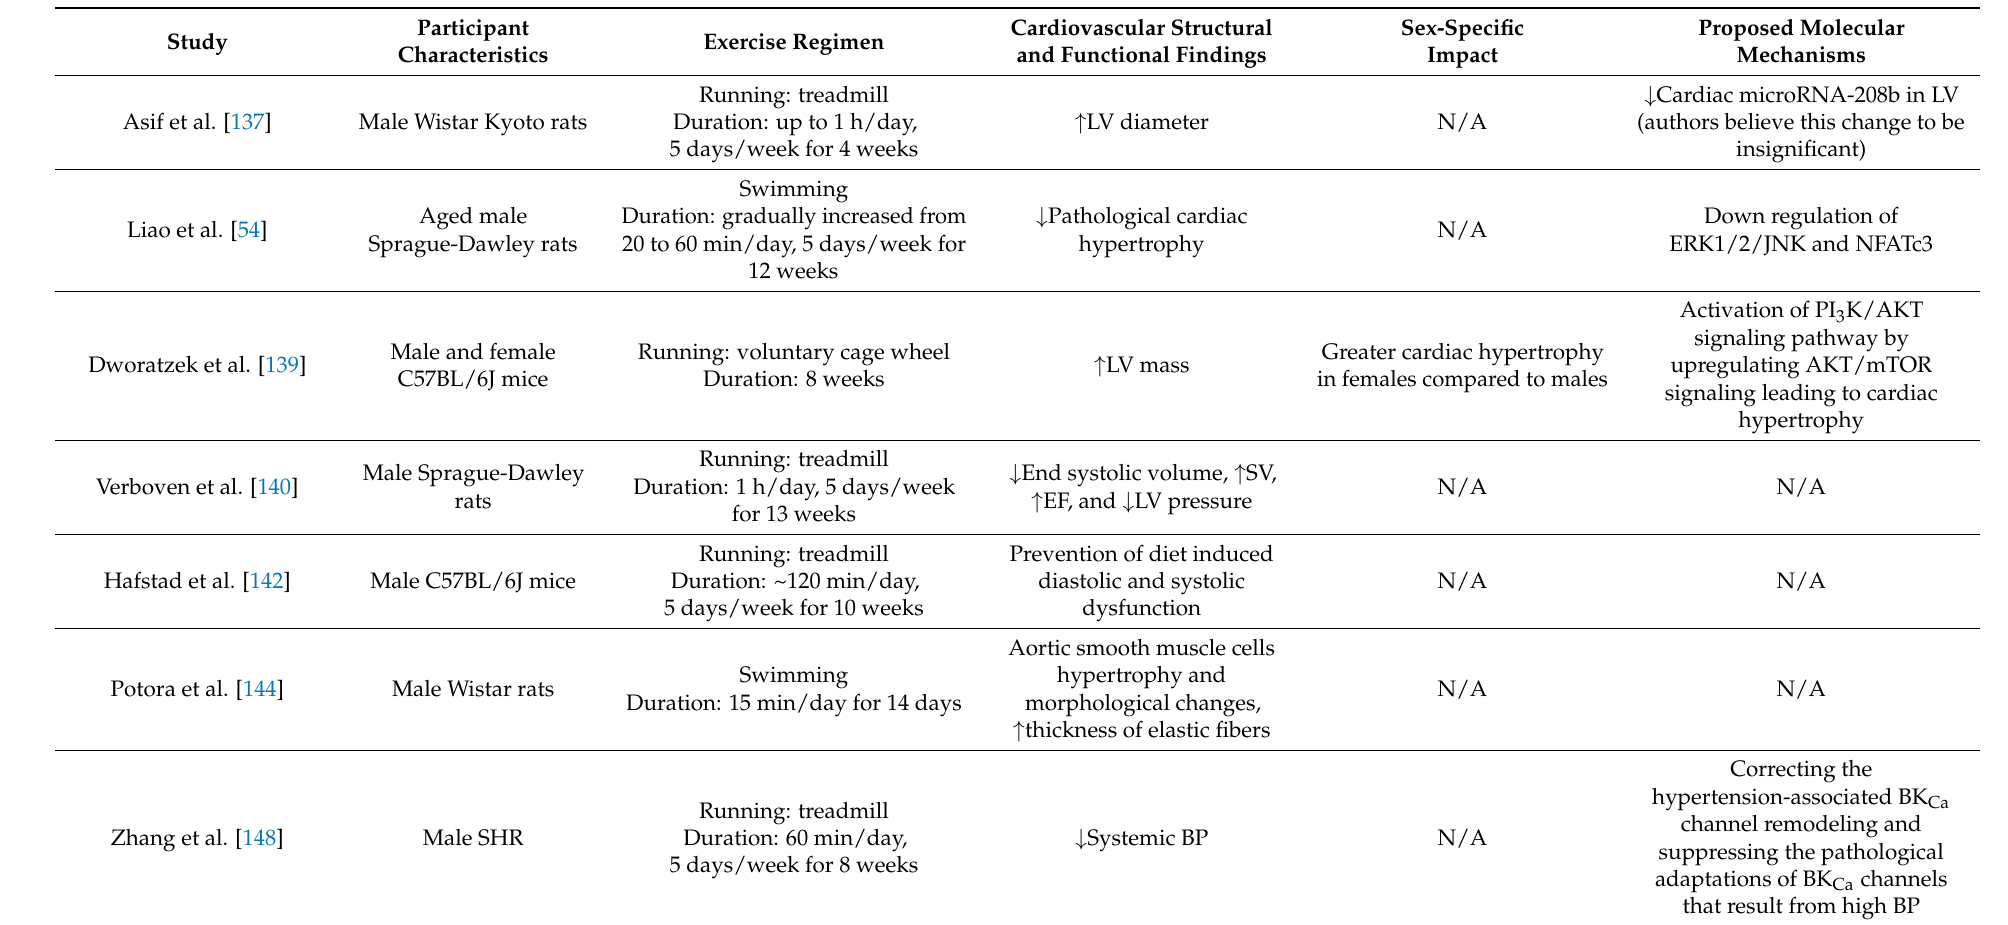
Table 3. The described studies associated with the low–moderate intensity training